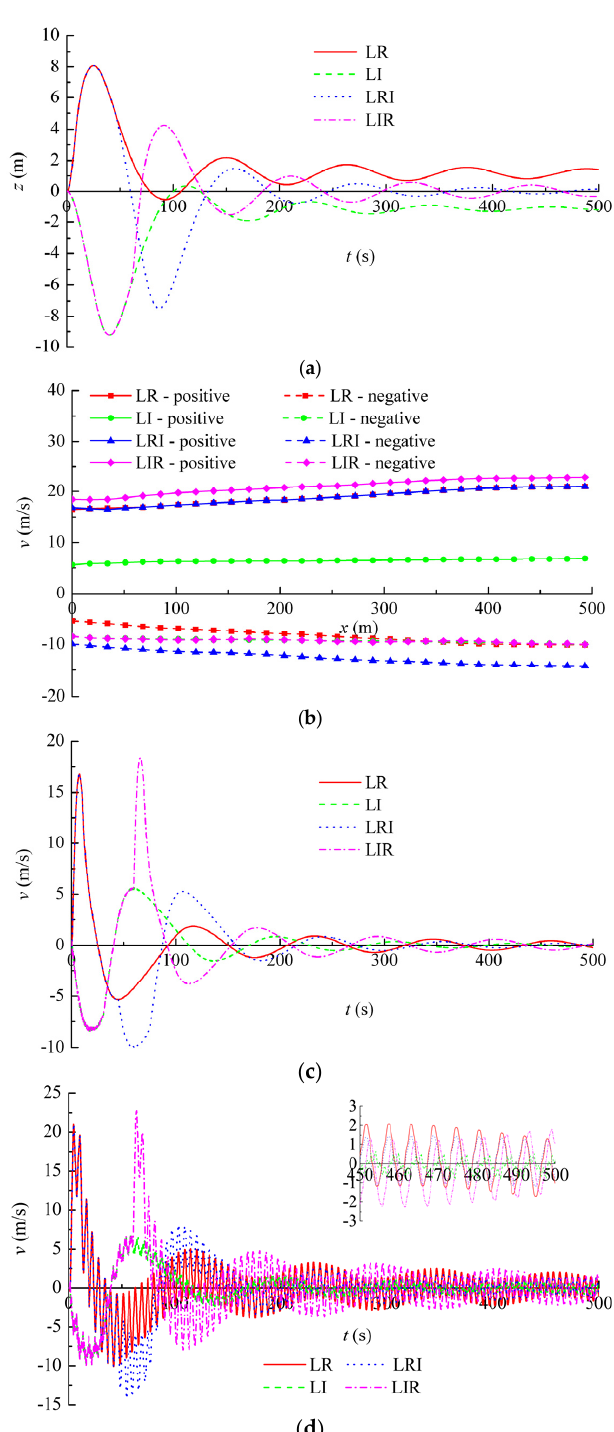
Figure 10. Effect on the processes of the water ‐ level fluctuation in a surge tank due to the wind speed of ventilation tunnel. ( a ) The processes of water ‐ level fluctuation of a surge tank under four typical operating conditions; ( b ) The positive and negative (extremum) envelope curves along the axis of ventilation tunnel; ( c ) The fluctuation processes of wind speed at the first section; ( d ) The fluctuation processes of wind speed at the last section.